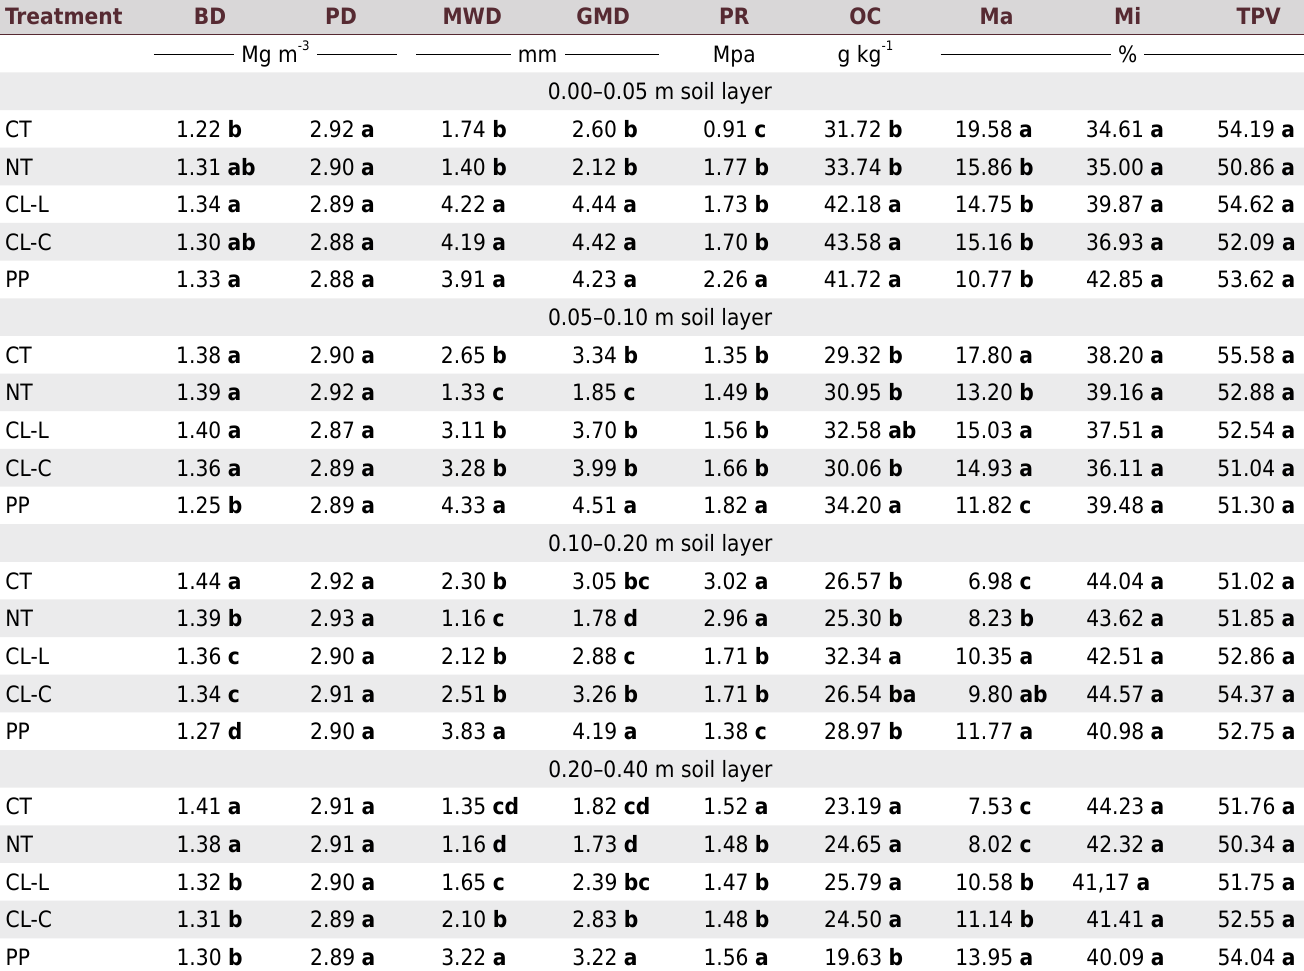
Table 2. Soil physical properties of Ferralsol under different agricultural management practices: Soil bulk density (BD), particle density (PD), mean weighted diameter (MWD), geometric mean diameter (GMD), soil penetration resistance (PR), organic carbon content (OC), macro- and microporosity (Ma and Mi), and the total pore volume (TPV) Treatment